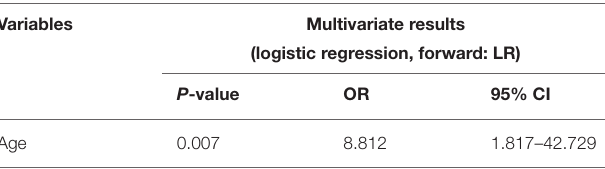
TABLE 5 | Multivariate logistic regression analysis for poor 6-month prognosis after primary DC. Variables Multivariate